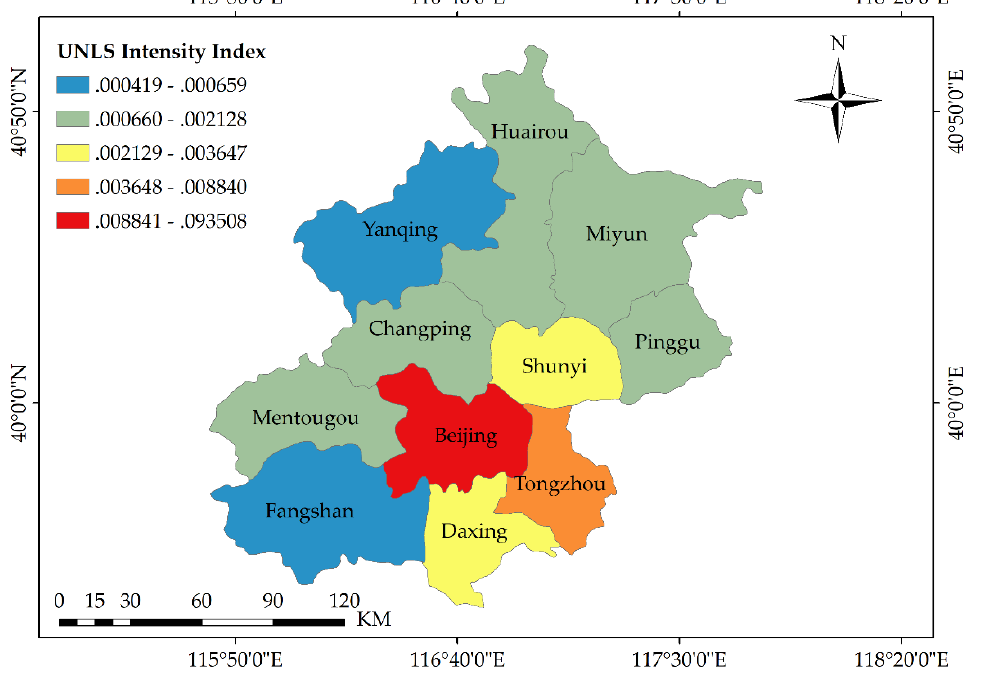
Figure 8. Intensity map of the UNLSs in Beijing.